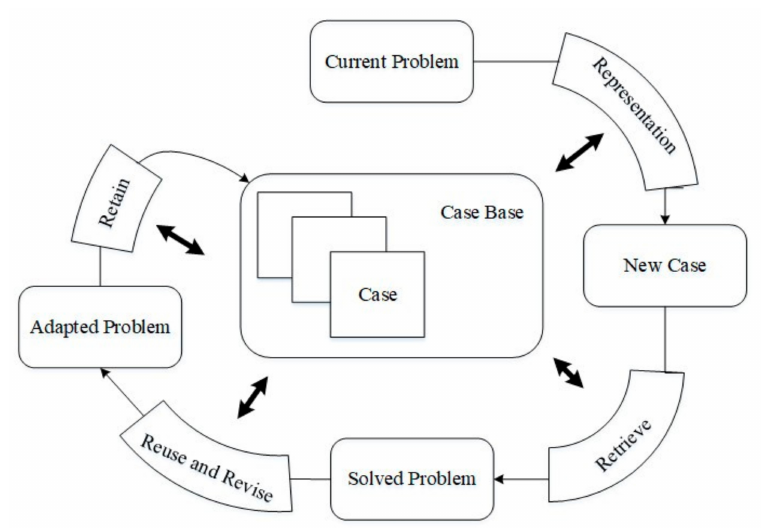
Figure 4. Process of the CBR